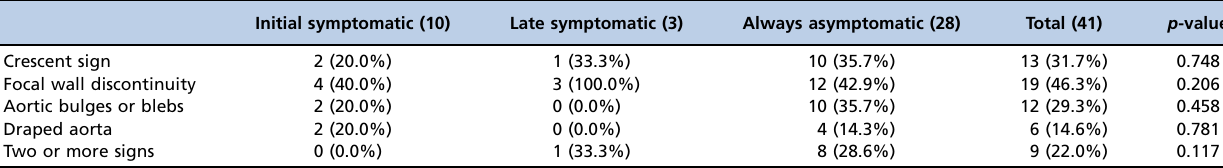
Table 3 - Signs observed by